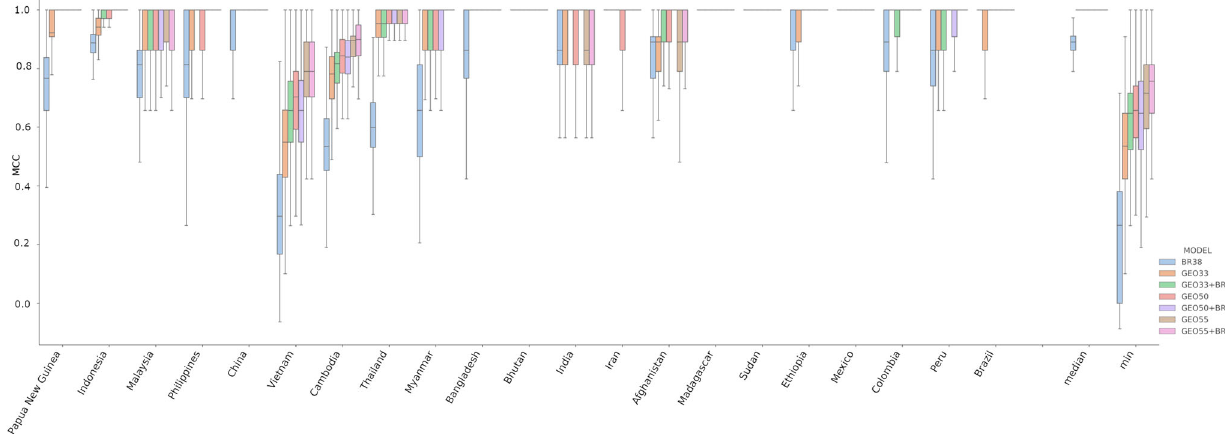
Fig. 2 Comparison of country prediction performance between the SNP panels. The boxplots present the MCC scores from 500 repeats with strati fi ed 10-fold cross validation for each SNP set. Country labels are provided on the y-axis; median and min re fl ect the respective summary statistics for the pooled MCC scores across all countries. Each bar presents the median, interquartile range and min and max MCC for the given country and model. The BR38 panel generally exhibited the lowest MCC scores (i.e., lowest prediction accuracy). Amongst the newly selected panels, GEO55 generally gave the highest MCC scores followed by GEO50, and then GEO33. The addition of the BR38 panel to the GEO panels generally only provided modest if any increase in the median MCC. The analyses were based on n = 799 biologically independent